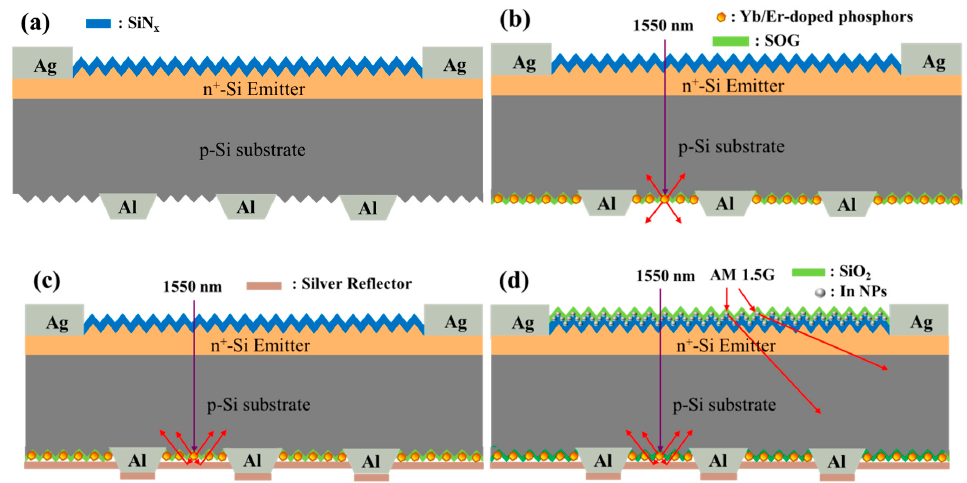
Figure 3. Schematic diagram showing ( a ) reference cell, ( b ) up-conversion (UC) cell, ( c ) UC cell with silver reflector (UC/Ag cell), ( d ) UC/Ag cell with In NPs embedded in SiO 2 (plasmonic UC/Ag cell).